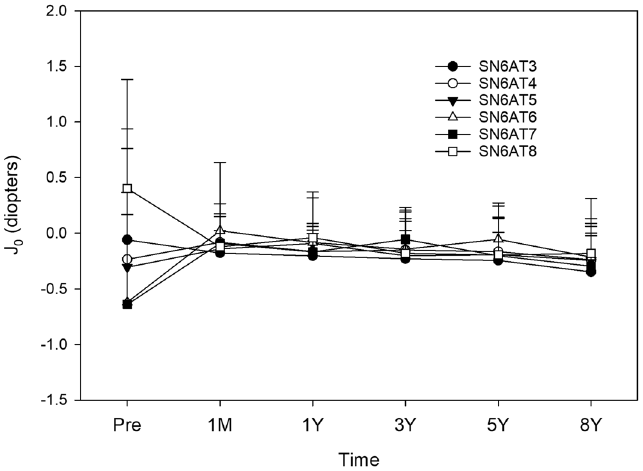
Figure 6. Time course of changes in J 0 by the model of toric IOLs. Postoperative J 0 values were not different among the models ( p >